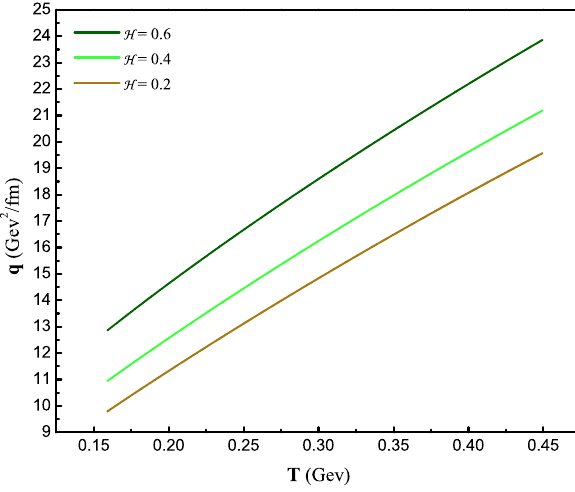
Fig. 4 Jet-quenching versus temperature in different E at z = 2, θ = d − 1 and Q = 1